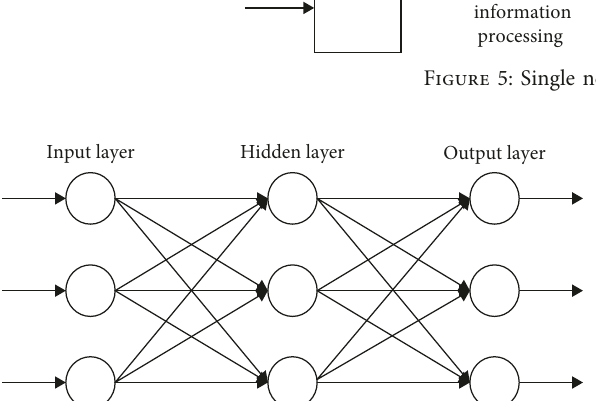
Figure 6: BP three-layer neural network structure diagram.